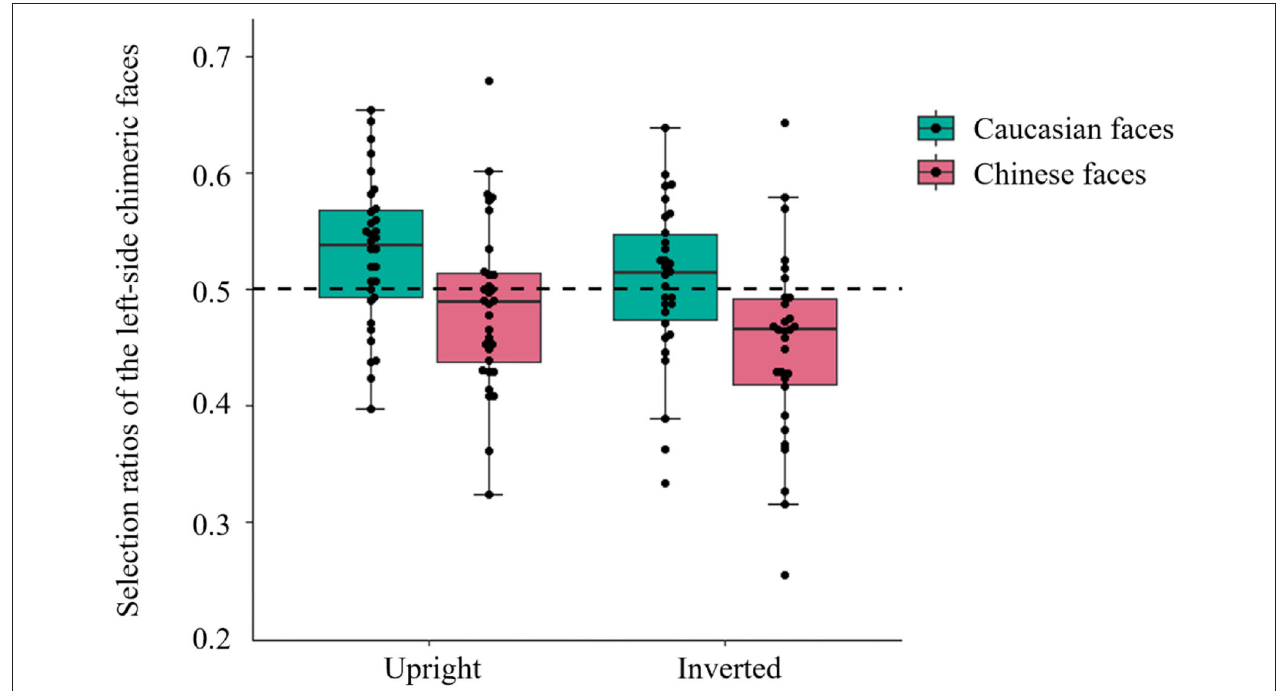
FIGURE 3 | Box plots of the selection ratios for left-side vs. right-side chimeric faces in each condition. The dashed line indicates an equal selection ratio for left-side and right-side chimeric faces. Each dot represents an individual